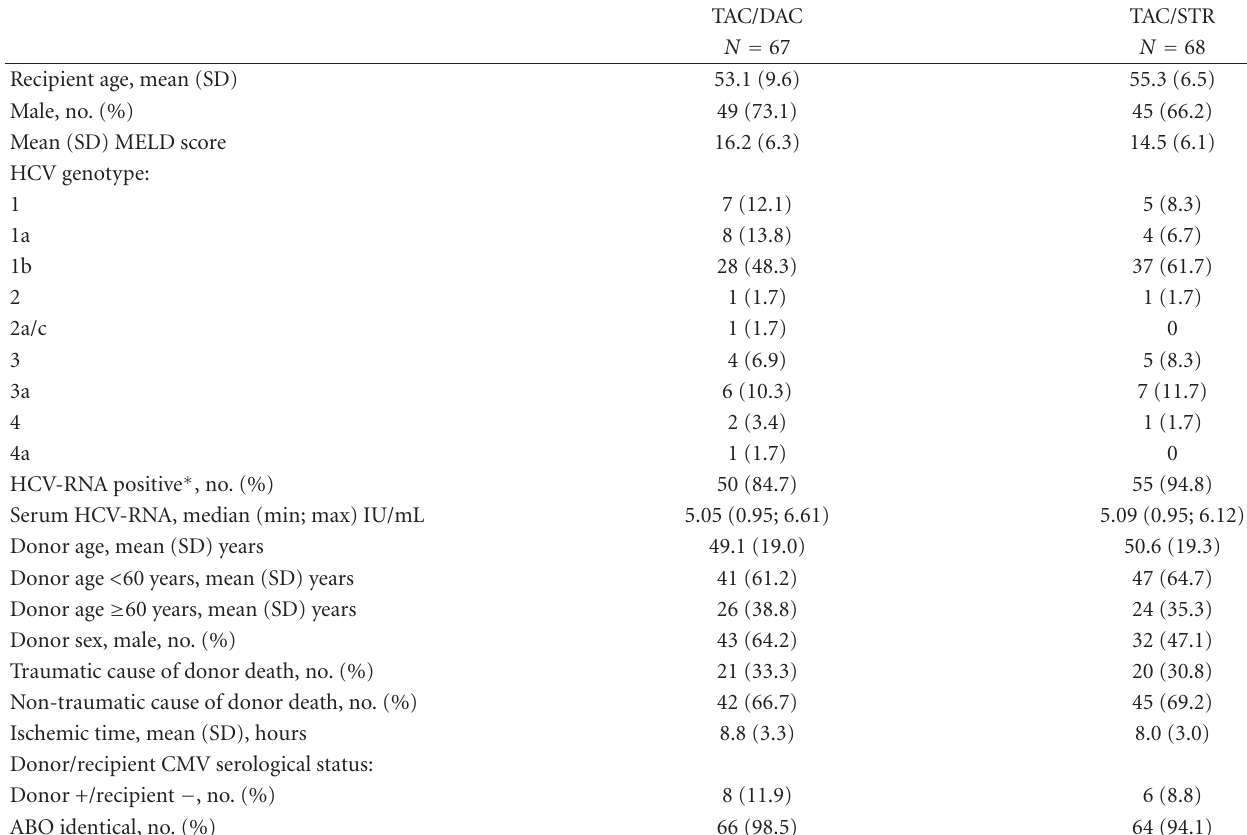
Table 1: Baseline recipient and donor characteristics of the FAS population.